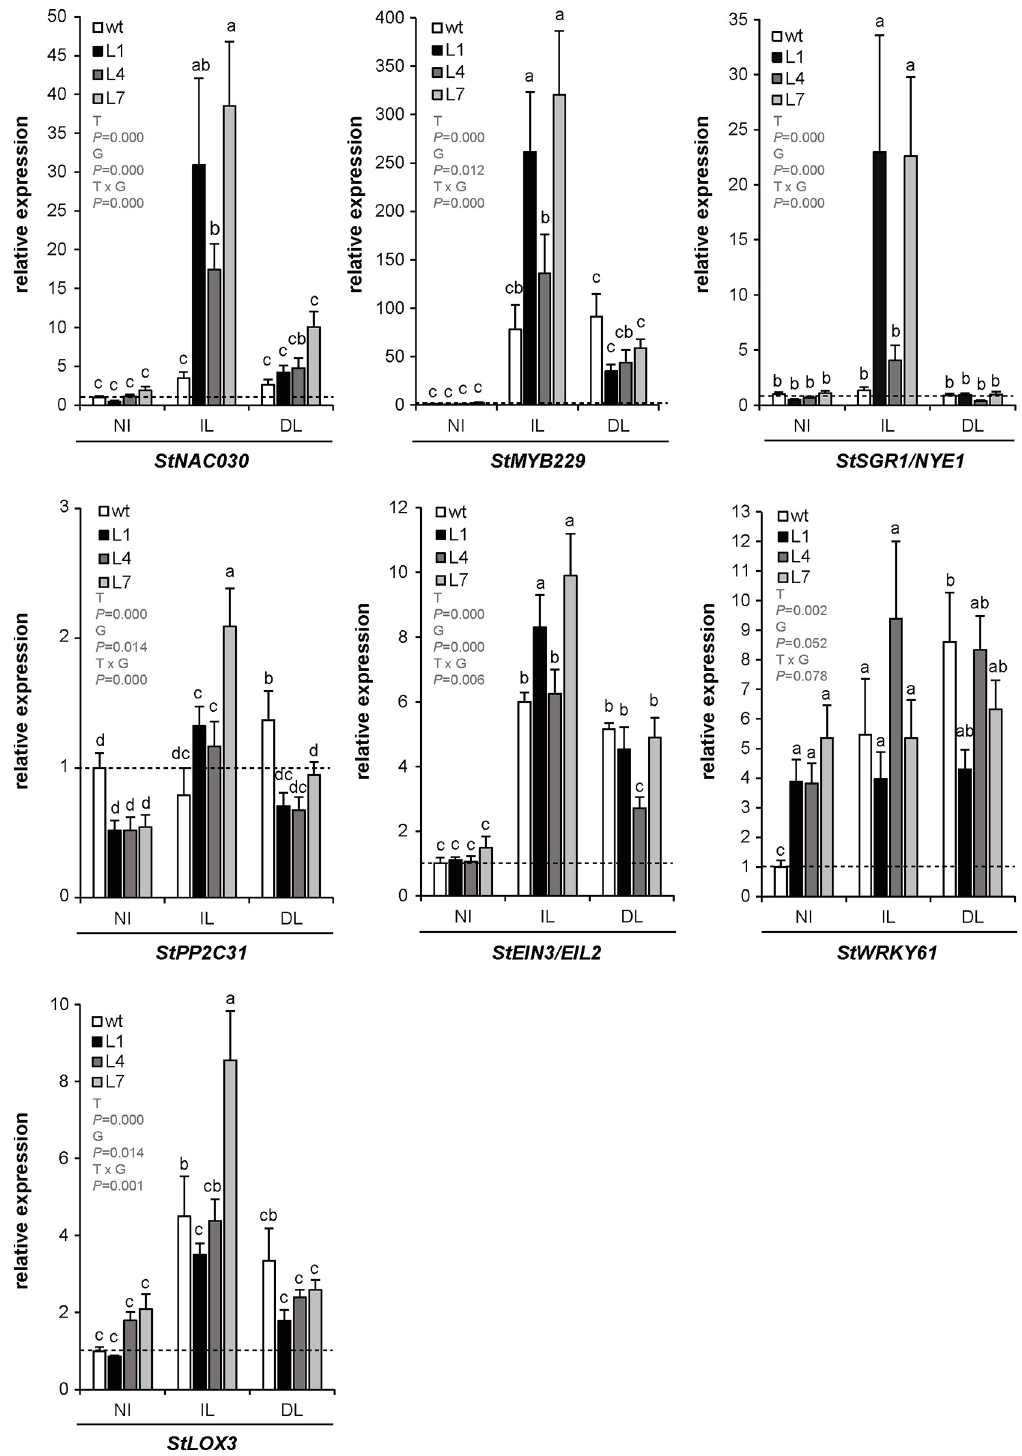
Fig 4. Expression of senescence marker genes in response to P . infestans infection. Wild type (wt) and PP2Ac2b-OE (L1, L4 and L7) plants were inoculated with P . infestans as described in Materials and Methods. After four dpi, expression was determined by RT-qPCR in leaves from non-infected plants (NI), infected leaves (IL) and distal leaves (DL), relative to wt NI (dashed line). Data are the mean ± SEM of three independent experiments. Data were analyzed by two-way ANOVA, followed by Bonferroni post-hoc test ( α = 0.05) comparing the expression levels for each line (wt, L1, L4 or L7) among NI, IL and DL,